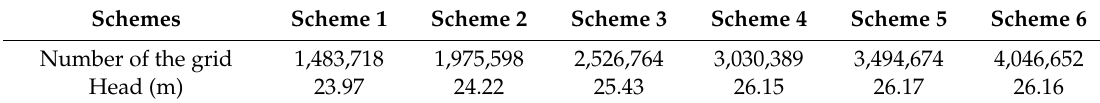
Table 2. The grid independence analyzation.